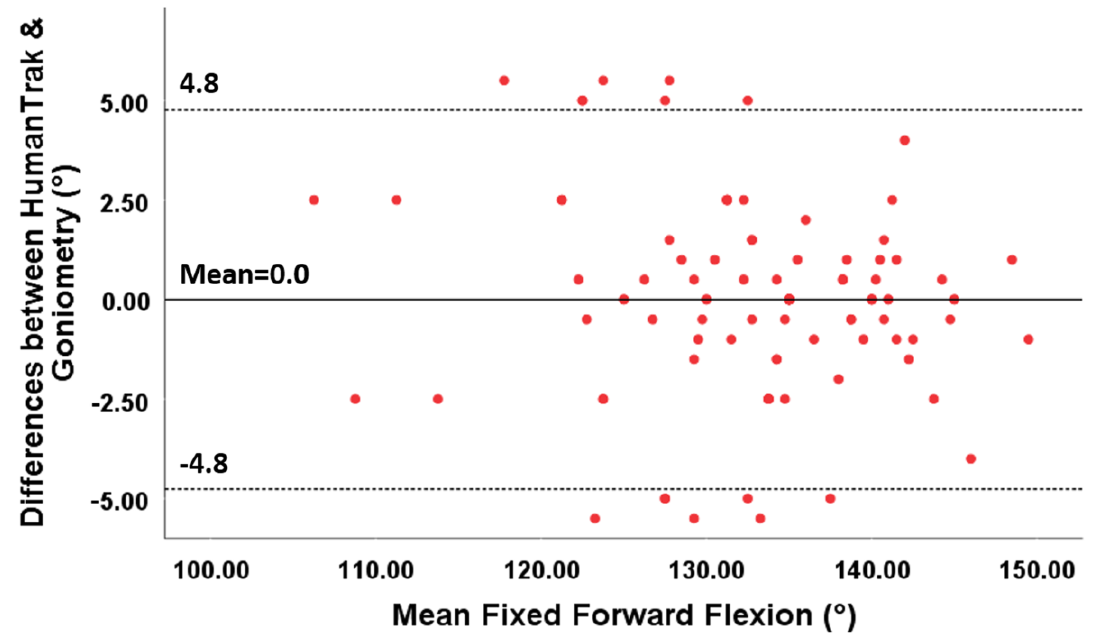
Figure 8. Bland–Altman plots for fixed forward flexion with limits of agreement. The differences between the two devices are plotted on the Y-axis, and the mean scores are plotted on the X-axis .